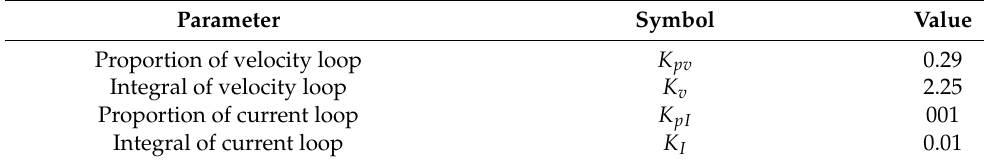
Table 2. Parameters of the controller.